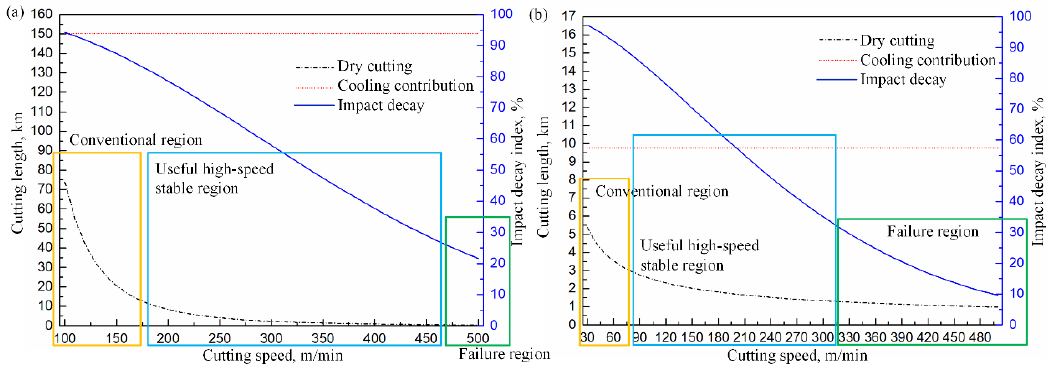
Figure 7. Tool life contribution components for dry cutting, cooling and impact of HUVC, ( a ) Ti alloys, feed per revolution and cutting depth are 0.005 mm/r and 0.05 mm, respectively, and ( b ) Ni alloys, feed per revolution and cutting depth are 0.005 mm/r and 0.2 mm, respectively. The cooling pressure and duty cycle are 10 MPa and 0.5, respectively.